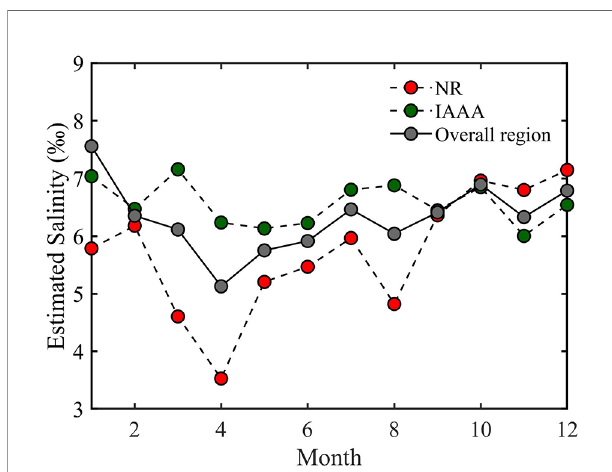
FIGURE 7 | Monthly mean variation of the estimated salinity from 2006 to 2018 in the nature reserves, the industrial and agricultural areas, and the overall Yellow River Delta.